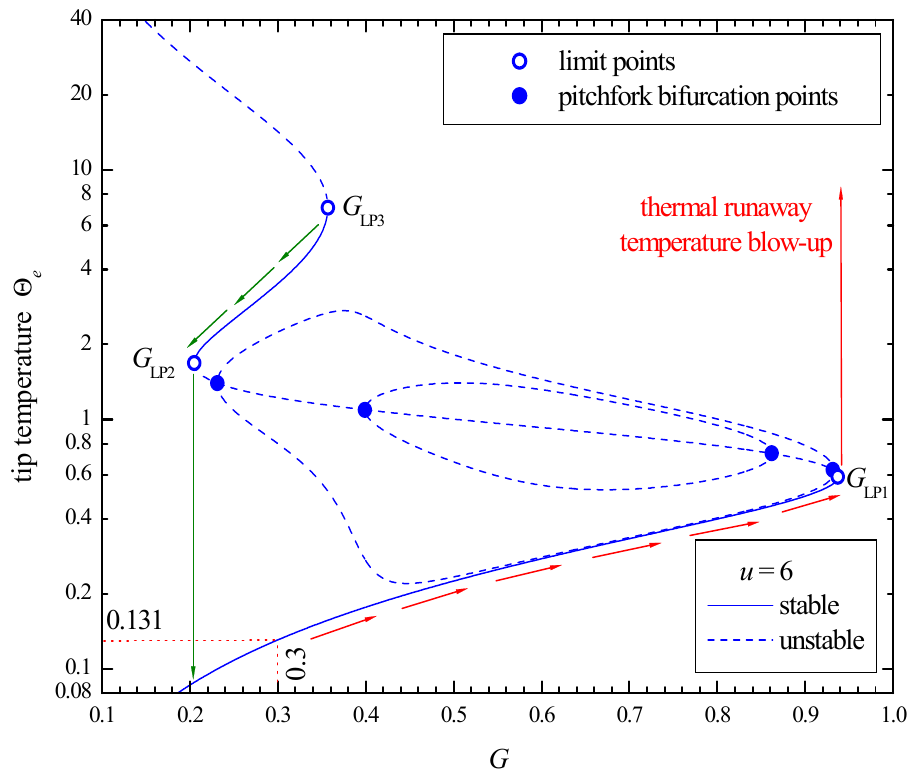
Figure 10. Solution structure at higher temperatures and thermal runaway.